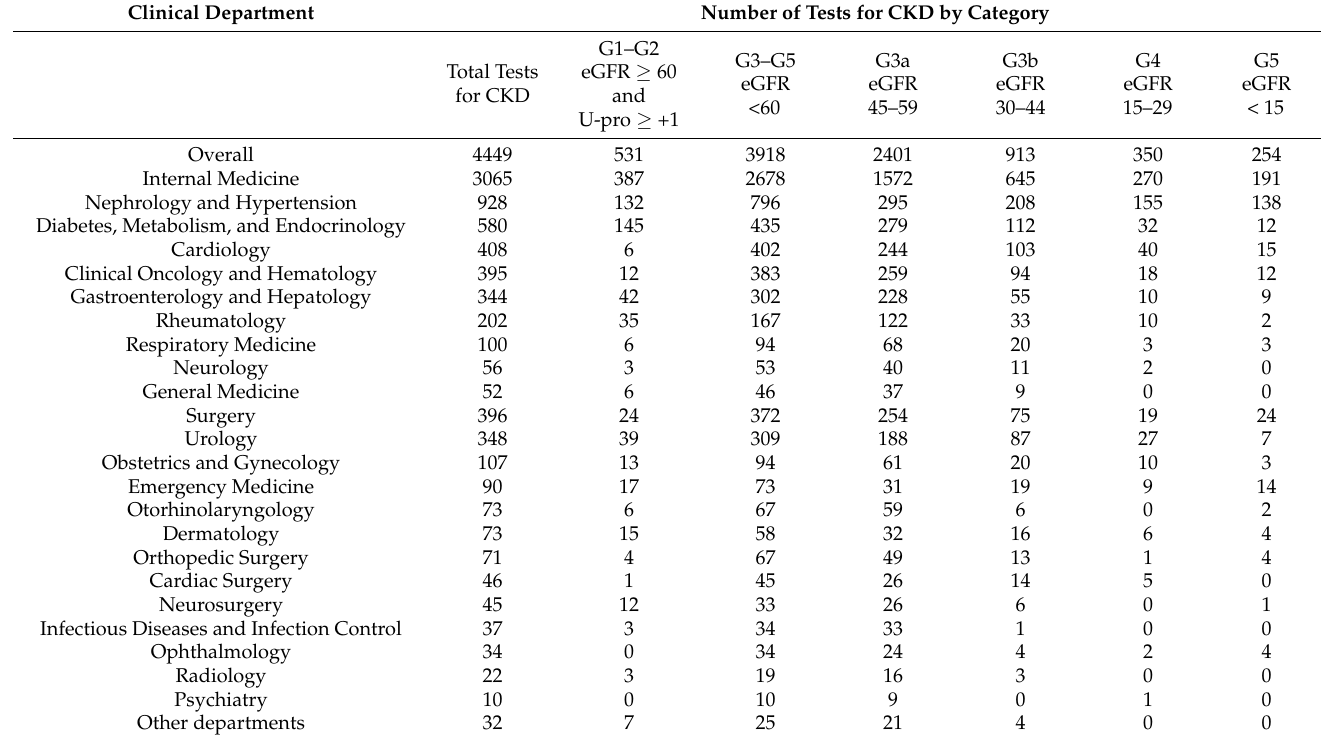
Table 2. The number of tests for CKD performed in each clinical department by CKD category.